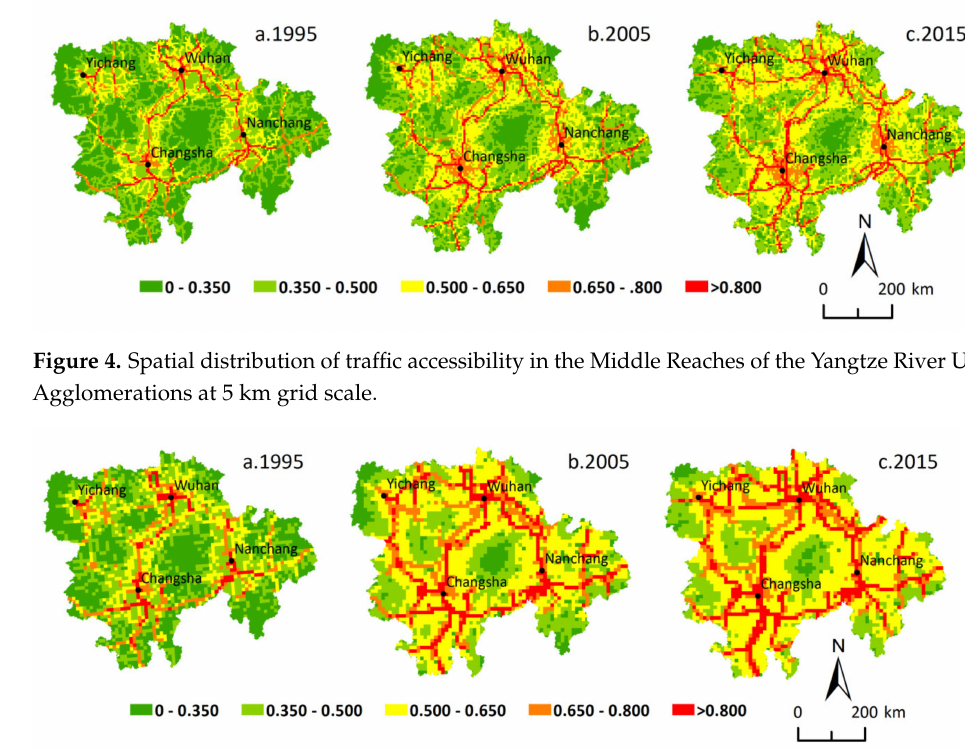
Figure 5. Spatial distribution of traffic accessibility in the Middle Reaches of the Yangtze River Urban Agglomerations at 10 km grid